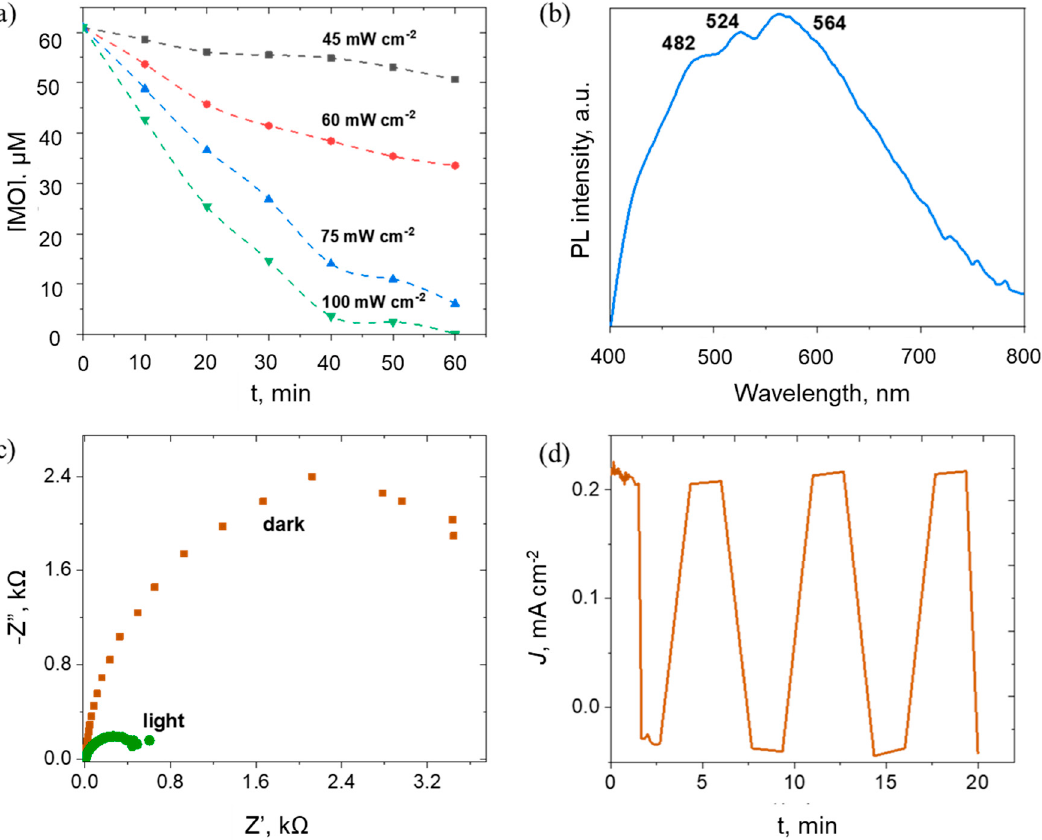
Figure 4. ( a ) Effect of light intensity on the MO dye degradation rate. ( b ) PL intensity of annTNA film for excitation at 375 nm. ( c ) EIS performed under light/dark conditions from 50 mHz to 500 kHz in 0.1 M Na 2 SO 4 electrolyte. ( d ) Chopped chronoamperometry test performed at 0.0 V (vs. Ag/AgCl).